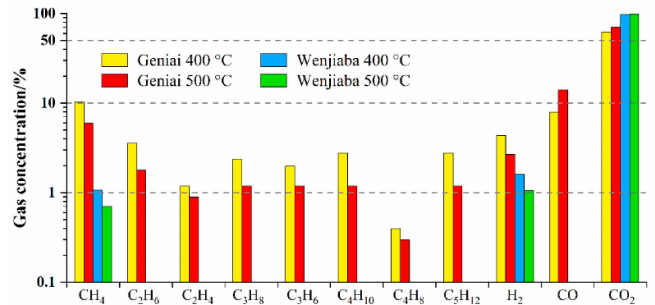
Figure 5. The concentrations of gases generated from shale pyrolysis at different